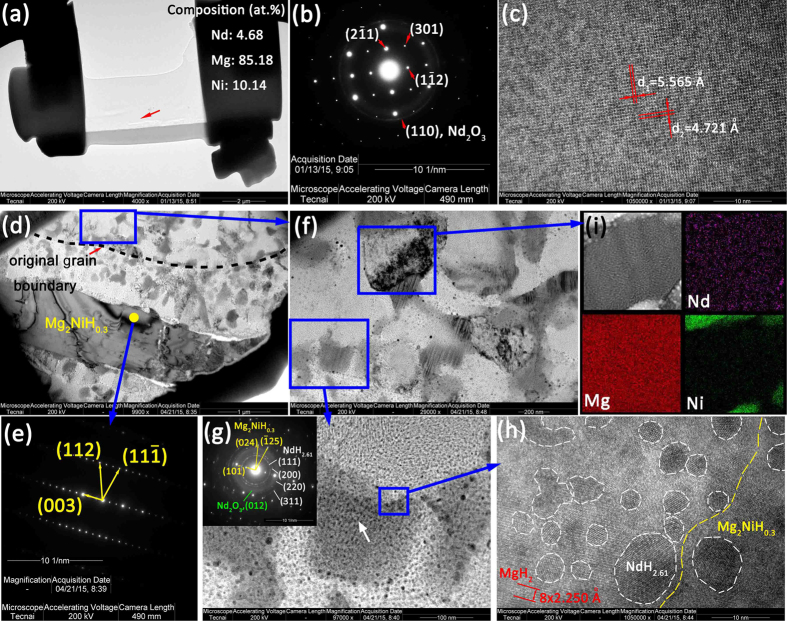
(a) The TEM bright-field image of Nd4Mg80Ni8, (b) the SAED pattern of Nd4Mg80Ni8, (c) HR-TEM image of Nd4Mg80Ni8, (d) the bright field image of incompletely hydrogenated Sample #6, (e) SAED pattern of Mg2NiH0.3, (f) the magnified image of the incompletely hydrogenated Nd4Mg80Ni8, (g) the magnified image of MgH2 and Mg2NiH0.3 and the SAED pattern of dark phase, (h) the HR-TEM image of MgH2/Mg2NiH0.3 interface, and (i) the composition map of Nd, Mg and Ni.